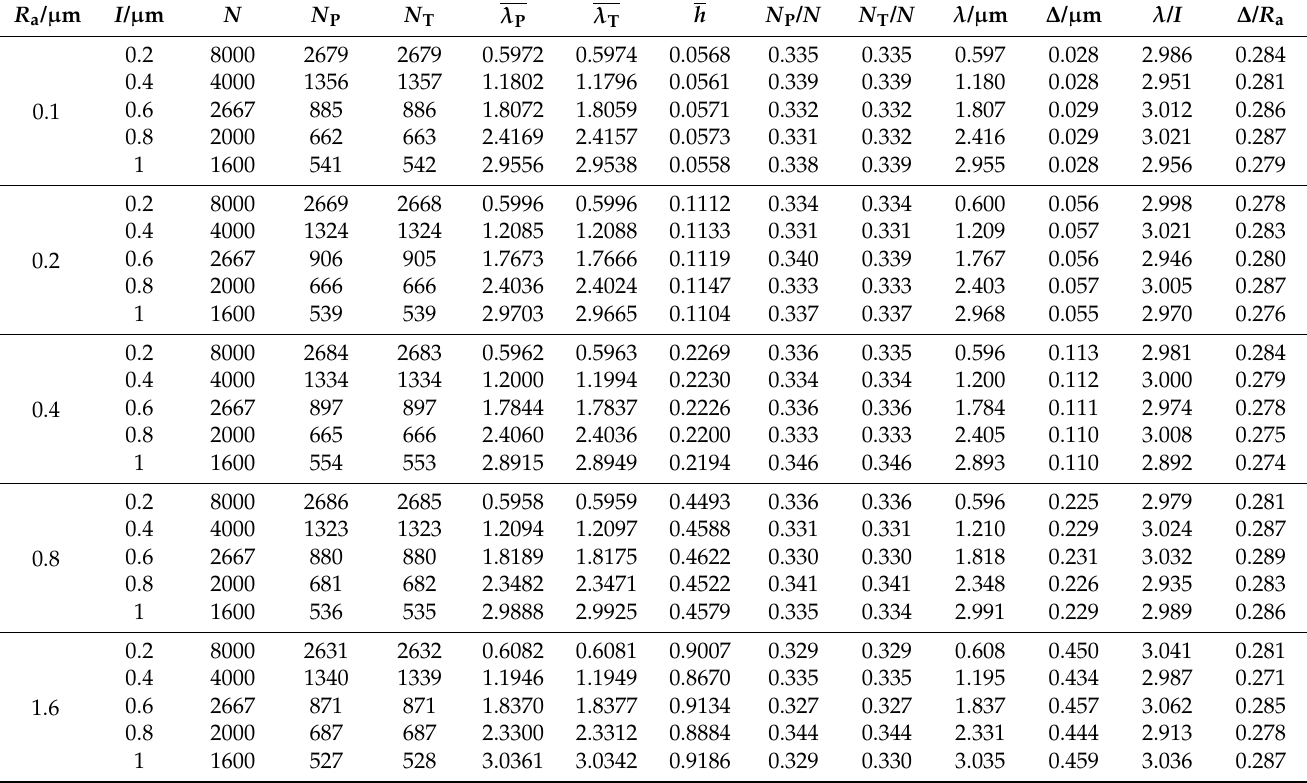
Table 2. Calculated parameters of simulated profile curves with different surface roughness values and sample